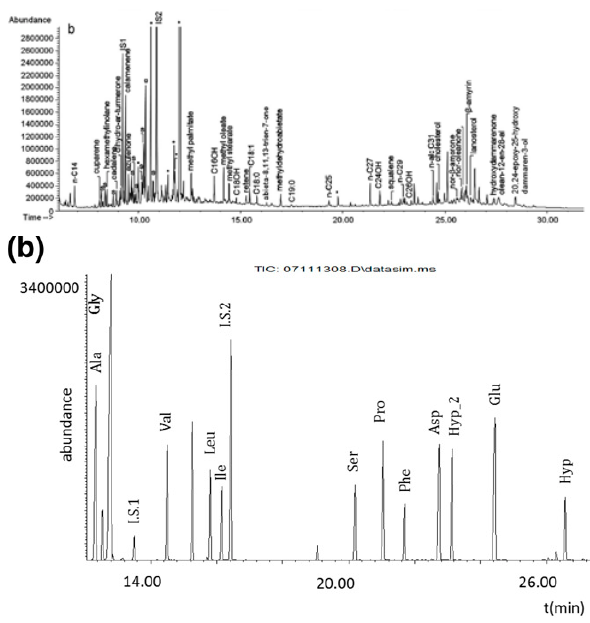
Figure 14. GC-MS of binding media in objects from Antiquity and Renaissance. Top panel: TIC chromatogram of sample of embalm- ing materials in Egyptian skulls (neutral fraction from extrac- tion). Sample from the archaeological collection, Natural History Museum, Florence, Italy. According analytes as TMS-derivatives . Column, fused silica capillary; T -program, MS: single quadrupole. For details see Supplementary Information and ref. [107] . From ref. [107] with permission. Bottom panel: capillary GC-MS of amino acid fraction of egg tempera sample from polyptych “Annunciation and Saints” (ca. 1385), Giovanni del Biondo (ca. 1356–1398), Galleria dell’Accademia, Florence, Italy; sample pretreatment and experi- mental conditions see ref. [104] . Taken from ref. [108] and